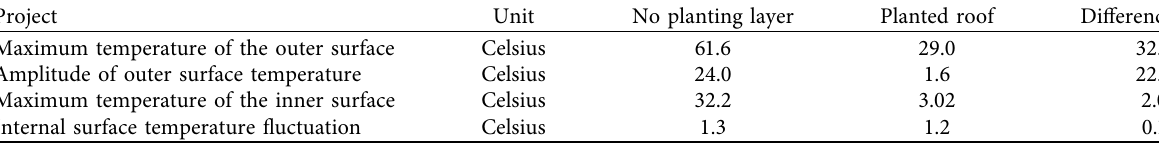
Table 1: Thermal measured values with and without planting